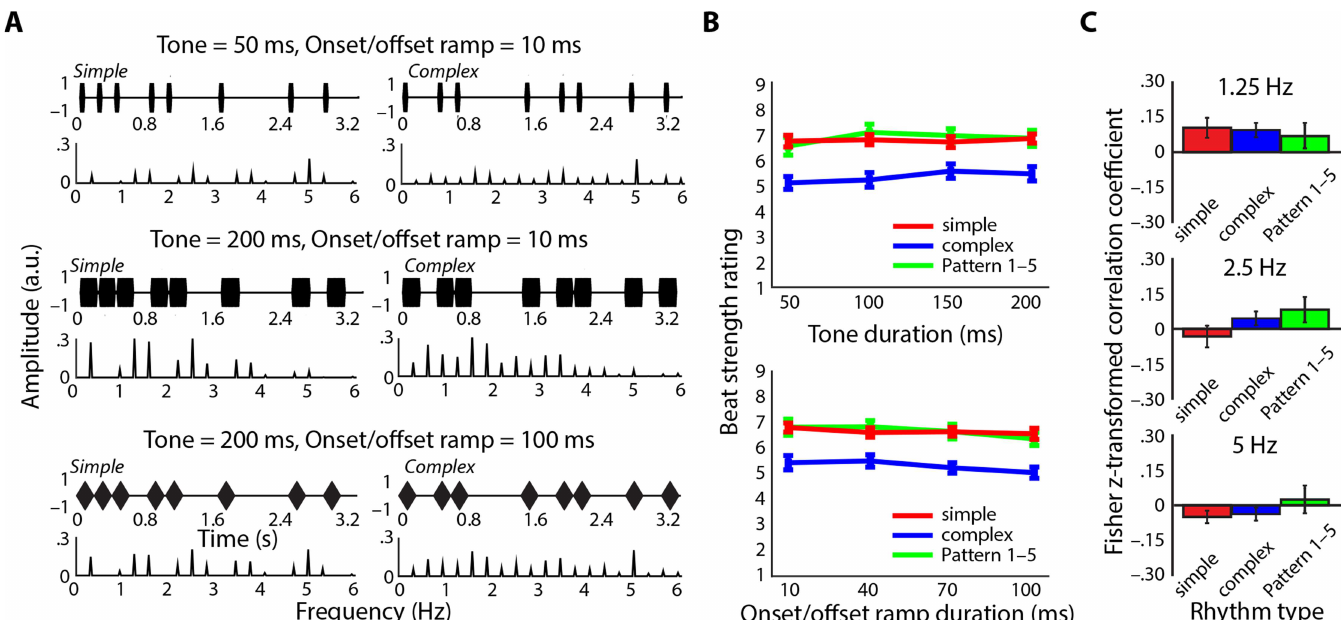
Fig 4. Beat perception does not depend on amplitudes at beat-related frequencies in stimulus spectra. A. Examplesof simple (left column) and complex(right column)rhythms used in Experiment 2a showntogether with amplitudespectra. Top: 50-ms tones with 10-ms onset/offset ramps; Middle: 200-ms tones with 10-ms onset/offset ramps; Bottom: 200-ms tones with 100-ms onset/offset ramps. Note the changesto the amplitudespectra that result from changingacousticstimulus features even for the same onset pattern. B. Beat strength ratings did not changeas a function of tone duration(top) or onset/offset ramp duration(bottom) despite their different amplitudespectra. Beat strength ratings did dependon onset pattern (i.e., whether the rhythm was simple or complex, shown in color). C. Beat strength ratings were not significantly correlatedwith amplitudes at beat-relatedfrequencies 1.25 Hz (top), 2.5 Hz (middle), or 5 Hz (bottom) for any rhythm type (colors same as B). Fisher z-transformed correlationcoefficients averaged across participantsare shown with standard error of the mean and were not significantly different from zero.